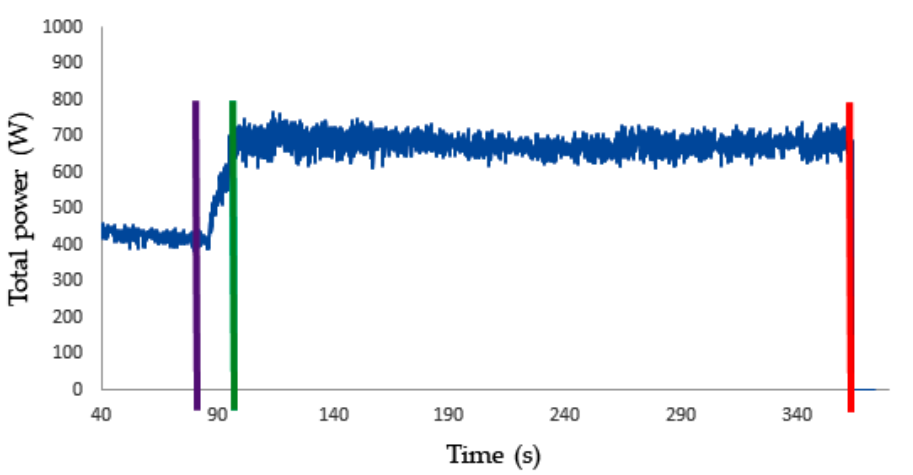
Figure 4. Diagram of the dependence of the total power of the electric motor on time.